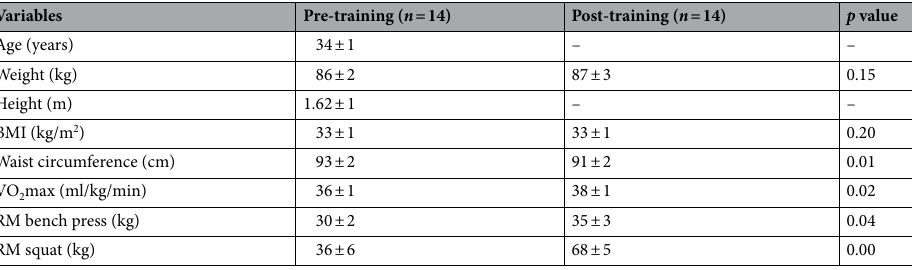
Table 1. Anthropometric and physical performance data of obese women before and after combined physical exercise (training). Data expressed as mean ± standard error of the mean. BMI body mass index, VO 2 max maximum oxygen consumption, RM Bench press upper limb strength, RM Squat lower limb